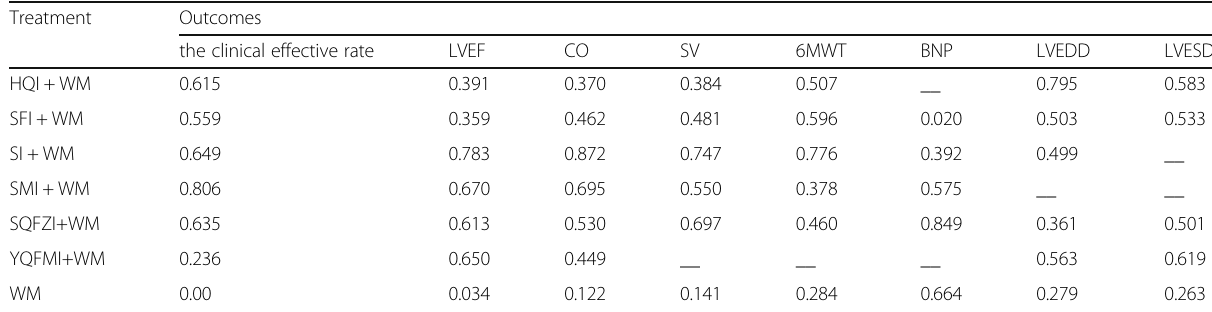
Table 5 Ranking probability for all treatments on the clinical effective rate, LVEF, CO, SV, 6MWT, BNP, LVEDD and LVESD Treatment